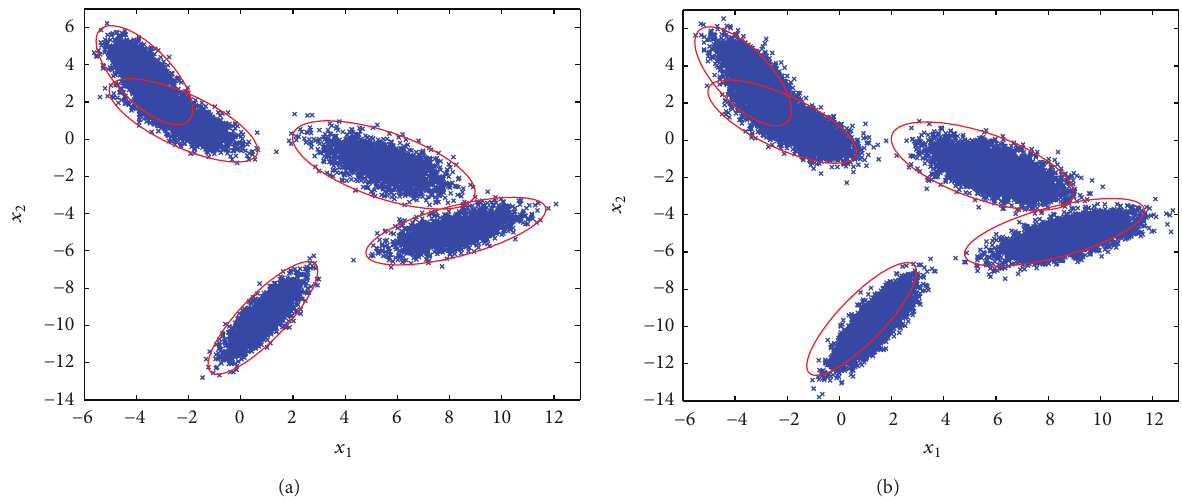
Figure 1: Training data (a) and test data (b) with a change in mean. The identified GMM model is shown in red.